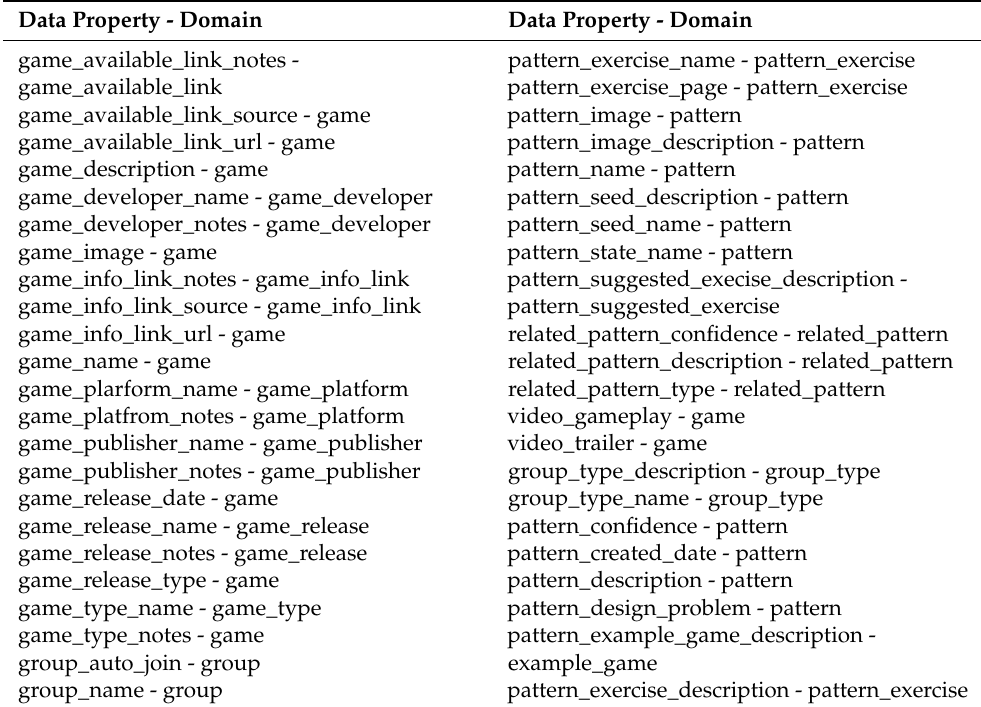
Table 3. Ontology data properties for representing a pattern. Data Property -